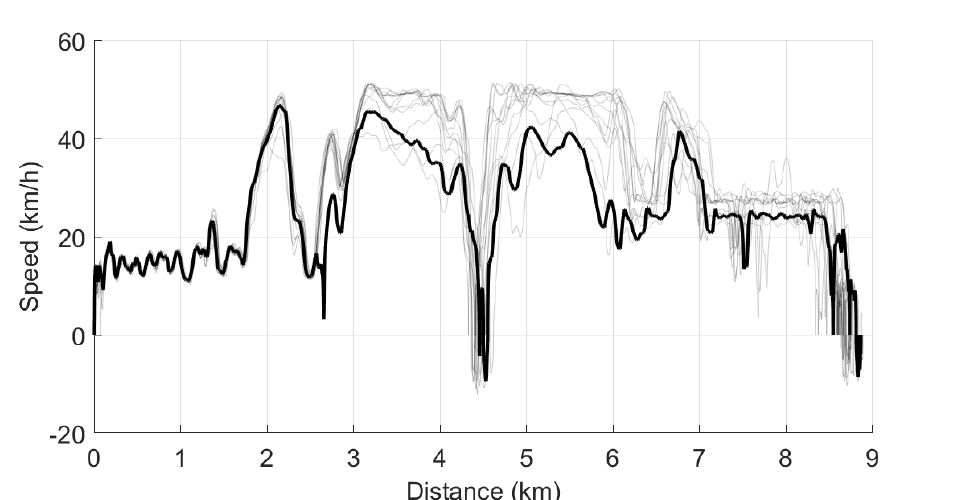
Figure 6. The measured speed during the 13 drive-cycles used in the model calibration. One drive cycle has been highlighted for clarity.